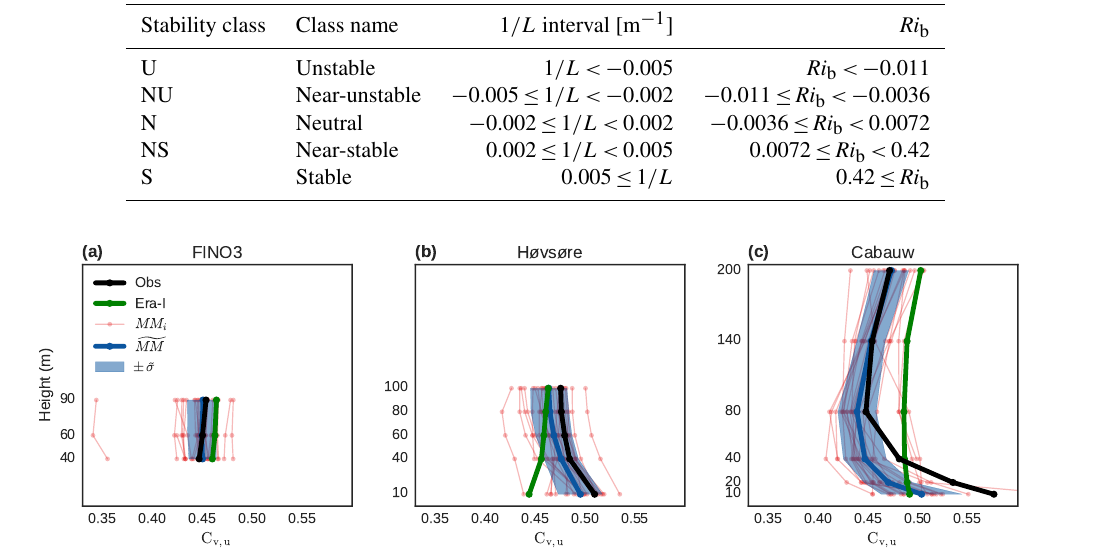
Figure 8. Vertical profiles of the coefficient of variation for wind speed C v ,u at the three sites for observations (black), ERA-Interim (green), the mesoscale models MM i (red), and the mesoscale models mean and inter-model variance g MM ± e σ (blue).